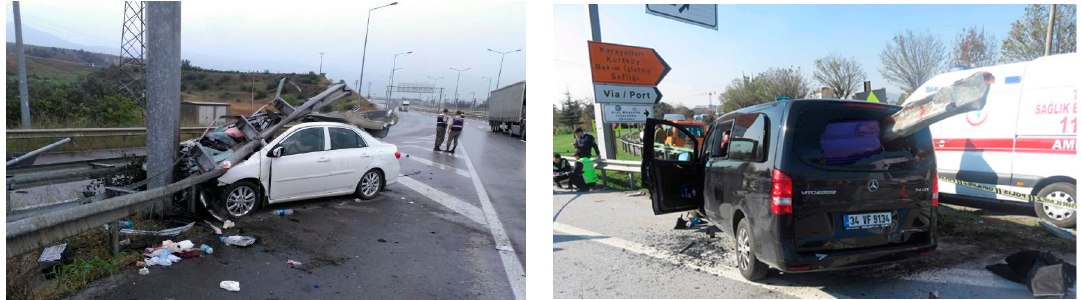
Figure 1. Severity of road accidents with narrow and rigid objects.